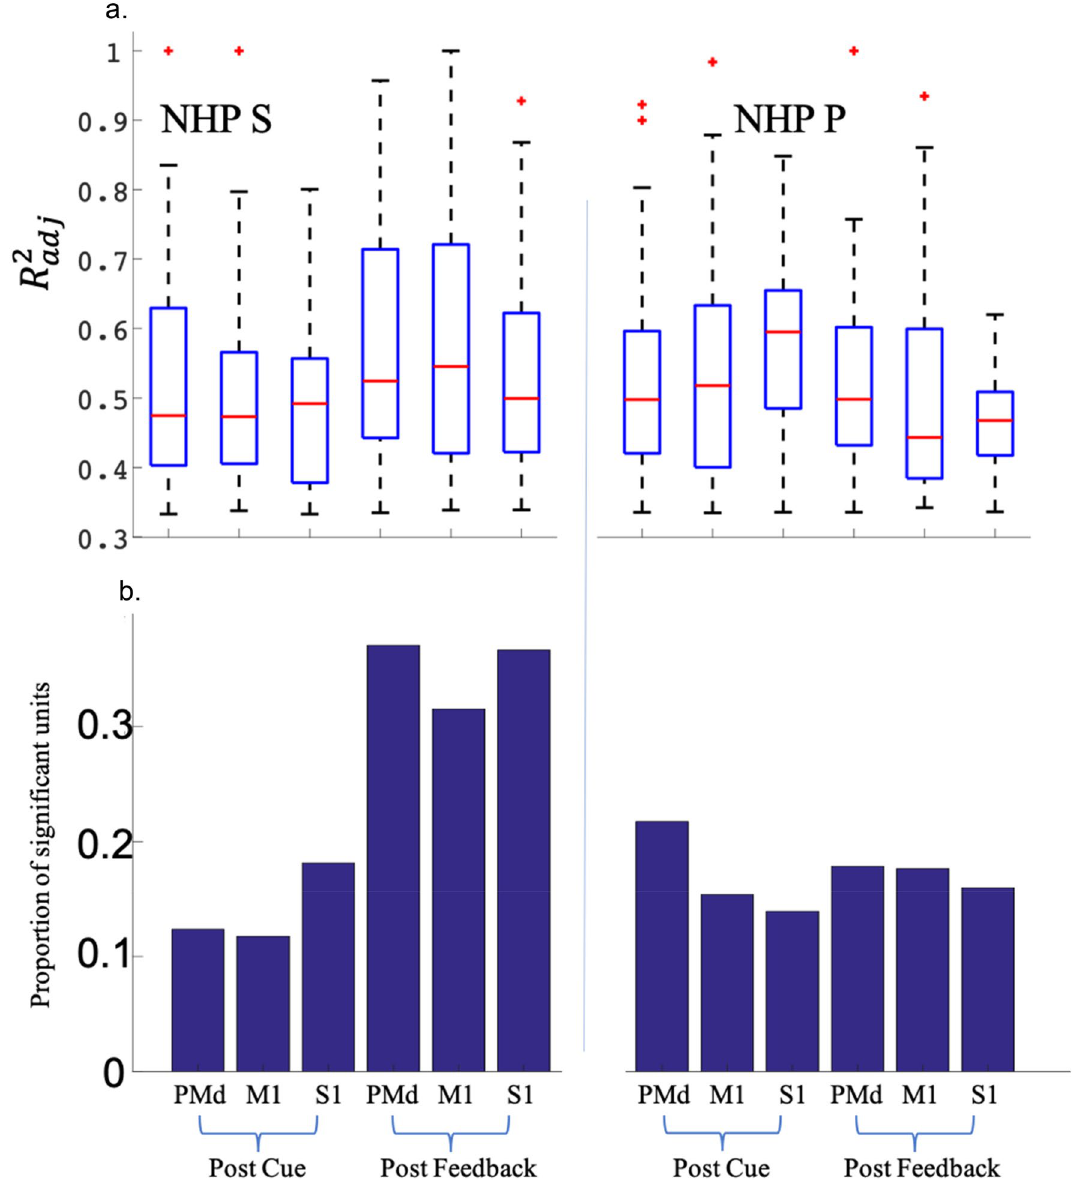
Figure 10. Medians and ranges for the adjusted R squared distributions are shown as boxplots ( a ) see main text for statistical differences between regions and task periods. The proportion of significant units for all brain regions is plotted in ( b